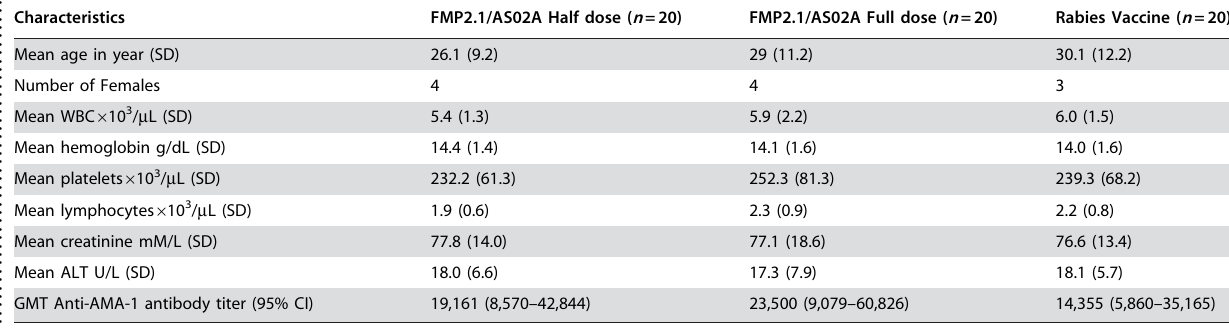
Table 1. Baseline Characteristics of FMP2.1/AS02A and Rabies Vaccine groups .. ... .... ... ... .... ... ... .... ... ... .... ... ... .... ... ... .... ... ... .... ... ... .... ... ... .... ... ... .... ... ... .... ... ... .... ... ... .... ... ... .... ... ... .